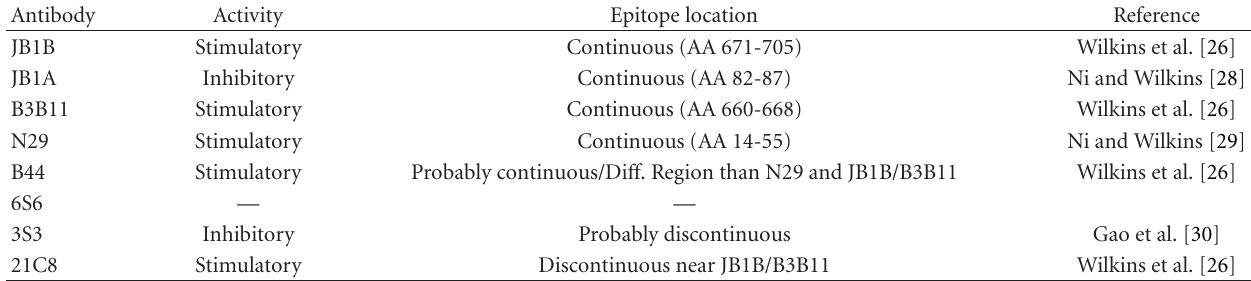
Table 1: Monoclonal anti-integrin β 1 antibodies used in this